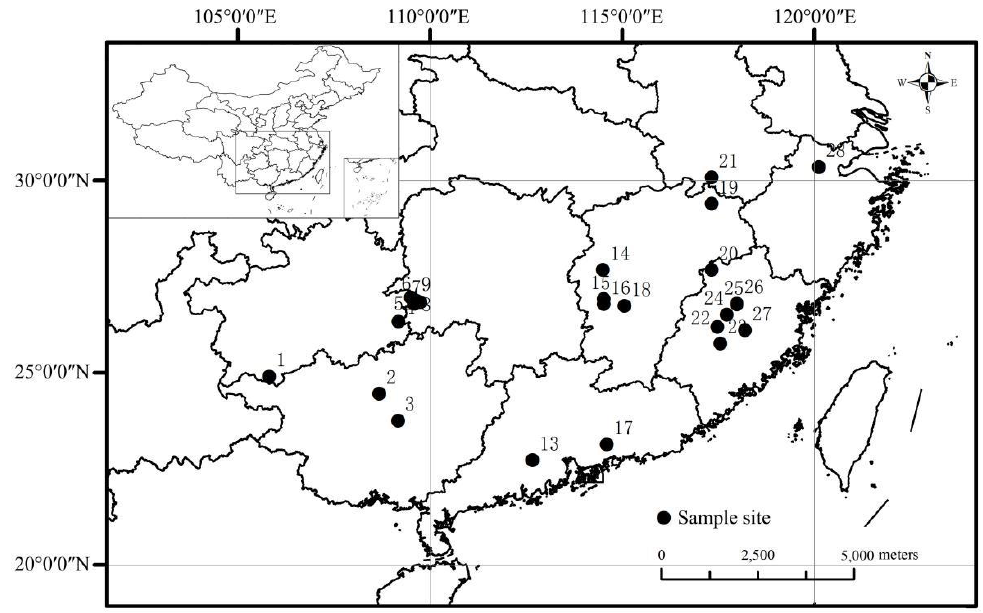
Figure 1. Distribution of the study areas. The small square stands in the Nansha Islands in China.